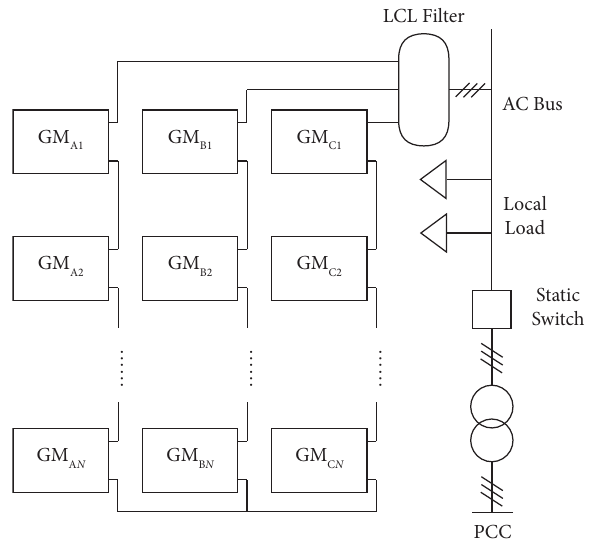
Figure 2: Topology structure of